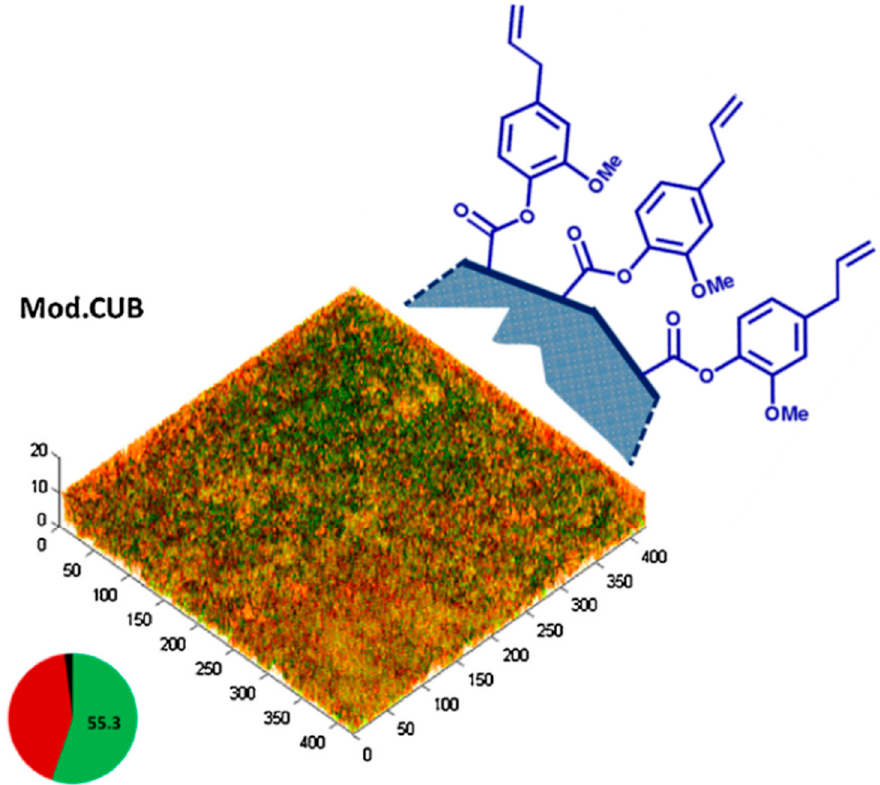
Figure 5. Schematic illustration of pendent eugenyl residues from the polymeric surface of the EgMA-containing resin composites (Mod.CUB) and microbial biofilms grown on cured resin discs tested with live/dead staining. The pie chart shows the effect of EgMA incorporation on the mean percentages of dead (red), live (green) and unknown (black) biovolumes. Adapted from Almaroof et al., 2017, with permission from Elsevier.